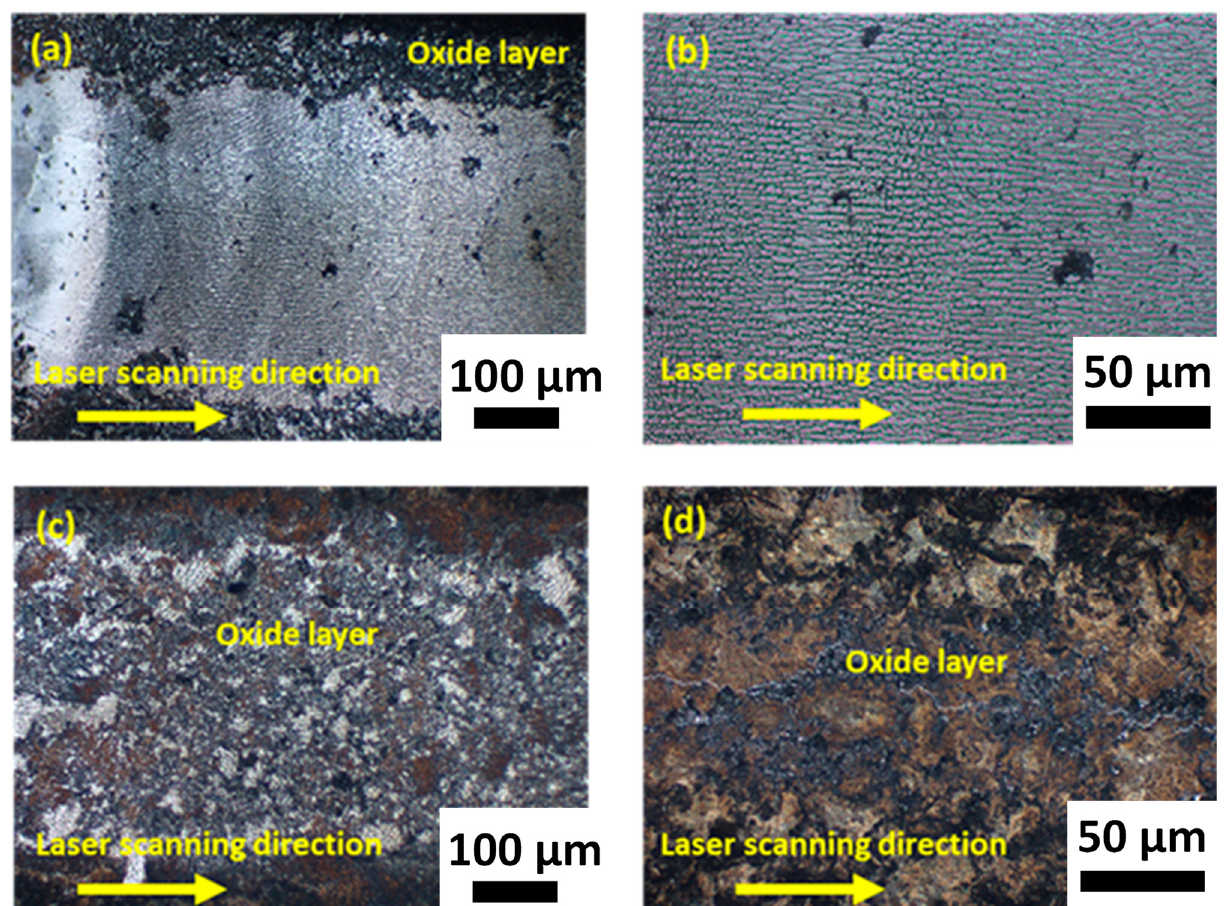
Figure 10. Optical micrographs of the surfaces of the substrates treated with ( a ) and ( b ) T1, ( c ) T2, and ( d ) T3 treatments.